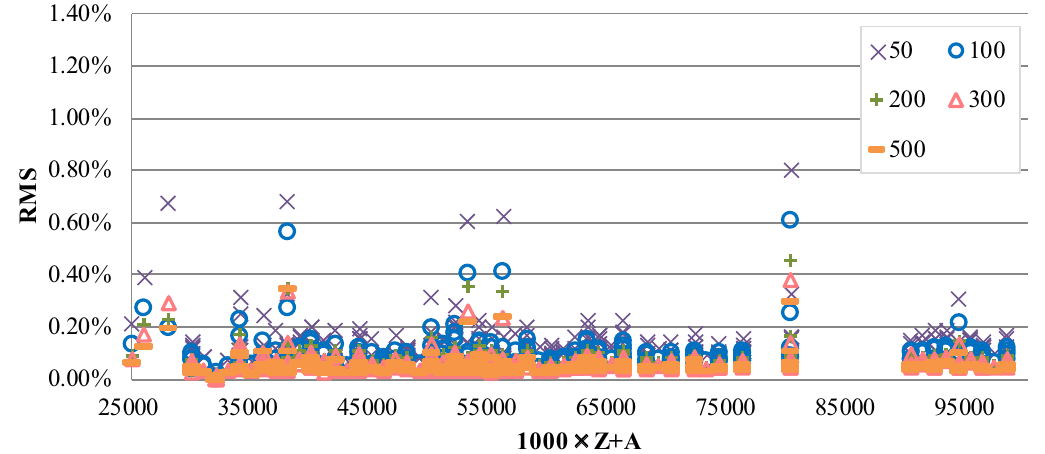
Figure 5. RMS values of probability table difference in each ladder number